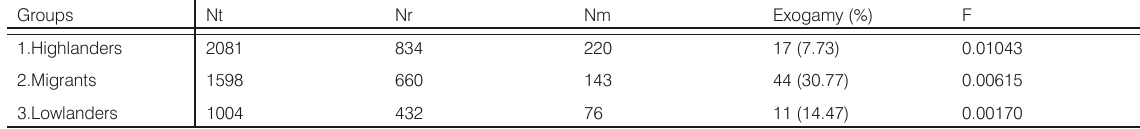
Table 2. Demographical structure of ‘split’ isolate highland (1) and migrant (2) parts in comparison with native lowlanders (3).